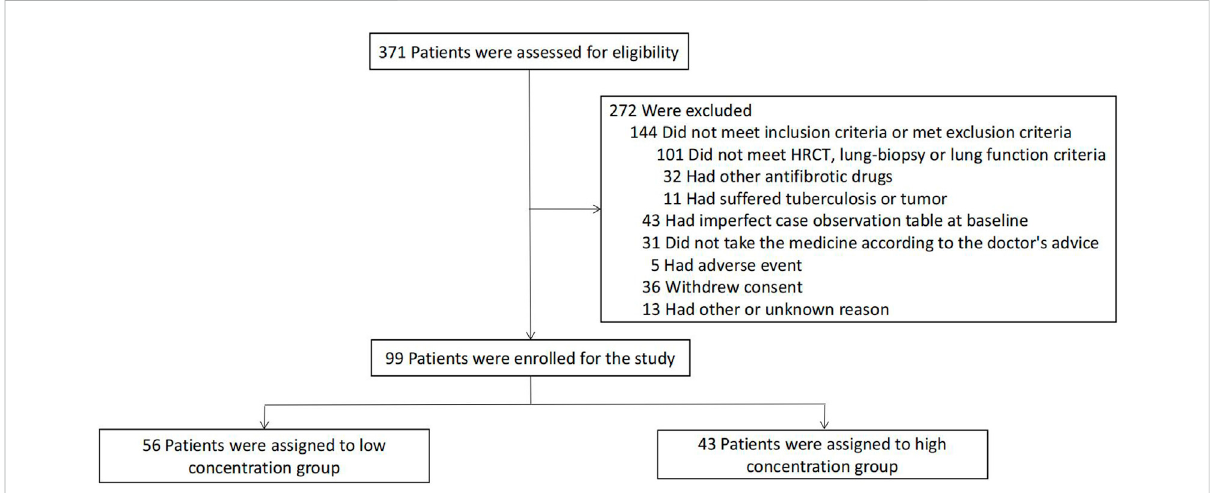
Enrollment and Grouped in the Overall Population. Patients could have more than one reason for exclusion. The numbers of patients who withdrew from the study do not include patients who died or underwent lung transplantation. Patients who discontinued the study treatment were included in the analysis of data for patients who completed the